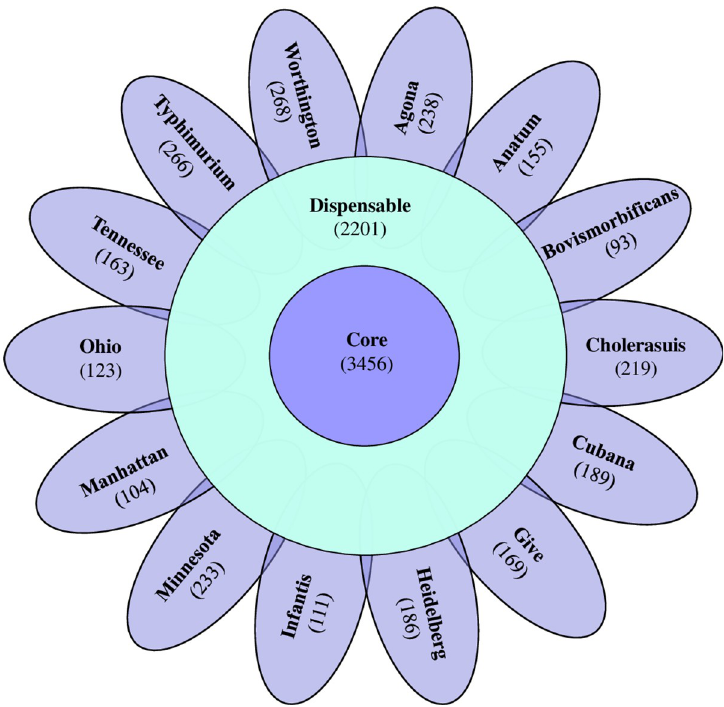
Fig 2. Floral venn diagram showing the pangenome of 14 Salmonella serovars from swine. The orthologus genes identified in all serovars presented in the center as core genes, orthologus genes identified among the serovars but not in all serovars presented in the periphery as accessary genes and each petals represents the unique genes in respective serotypes.